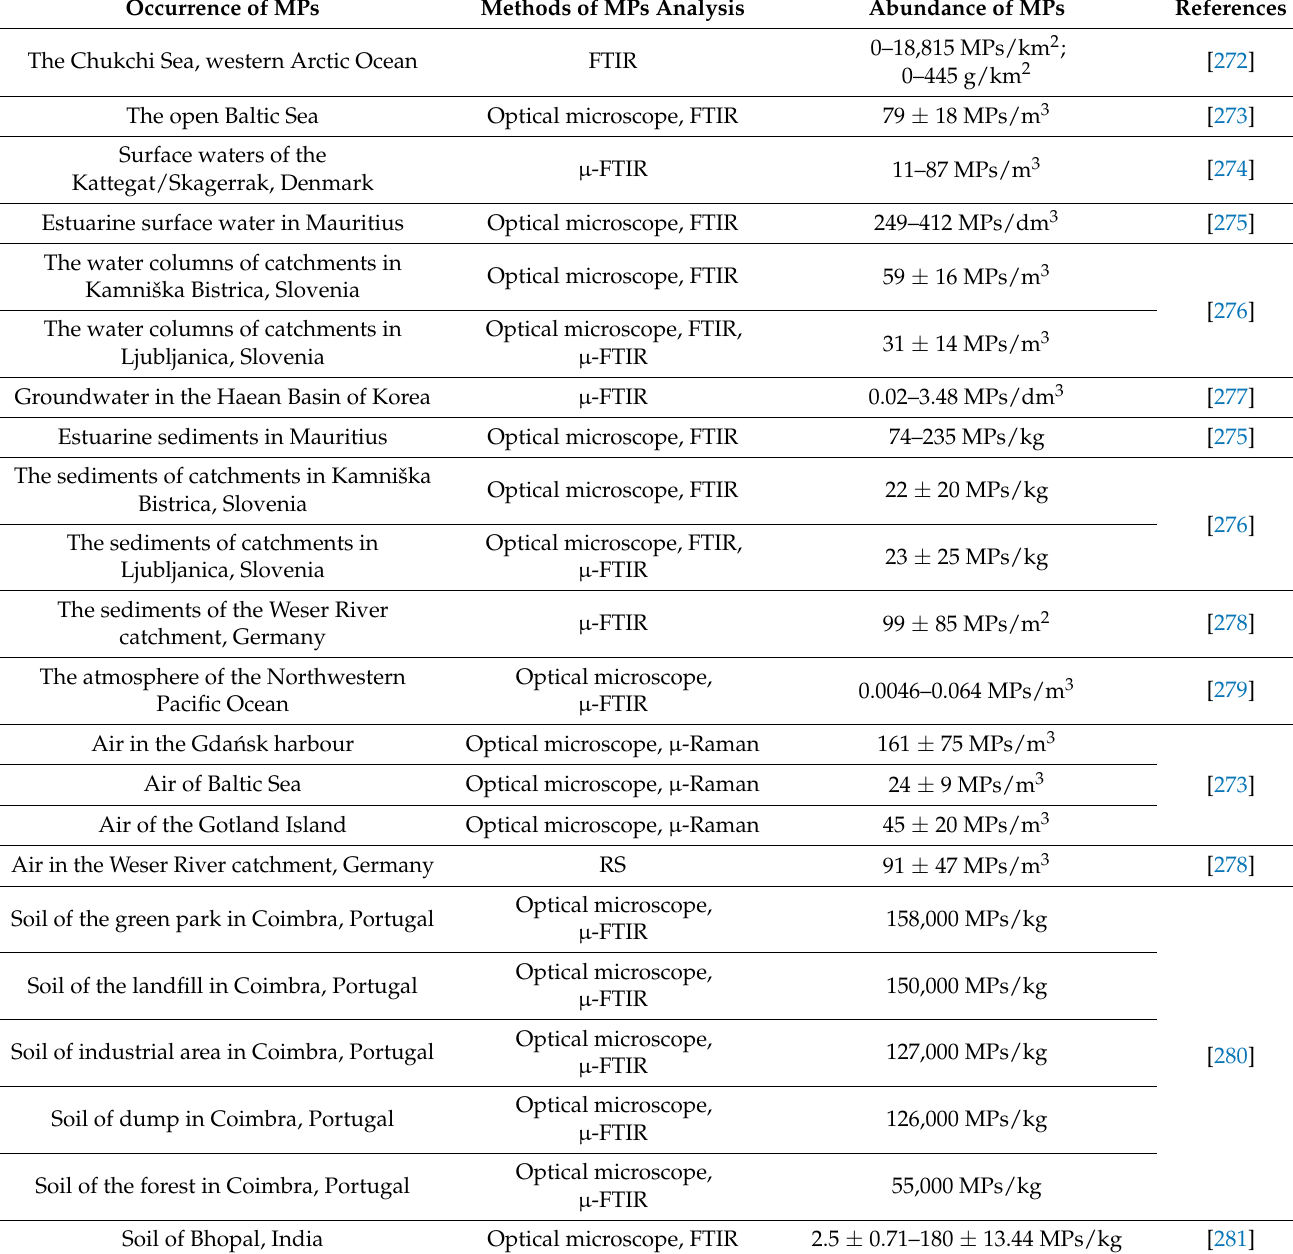
Table 5. Occurrence, analysis, and abundance of MPs in the